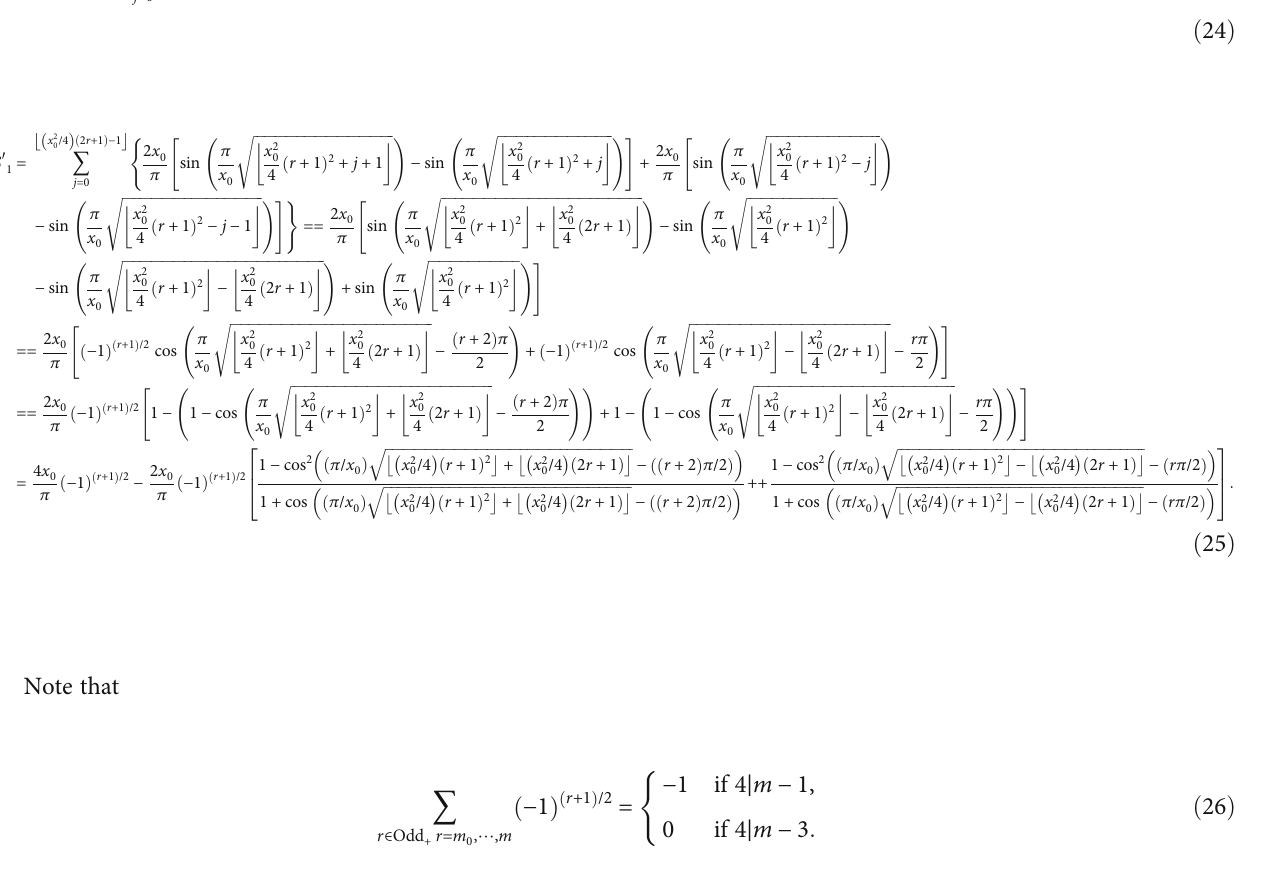
ffiffiffiffiffiffiffiffiffiffiffiffiffiffiffiffiffiffiffiffiffiffiffiffiffiffiffiffiffiffiffi x 0